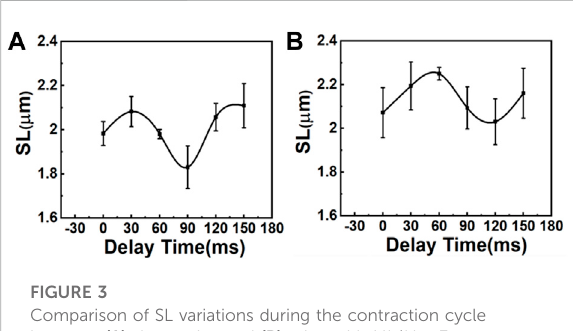
FIGURE 3 Comparison of SL variations during the contraction cycle between (A) sham mice and (B) mice with MI ( N = 3, mean ± standard deviation). The variation of SL is larger in sham mice than in mice with